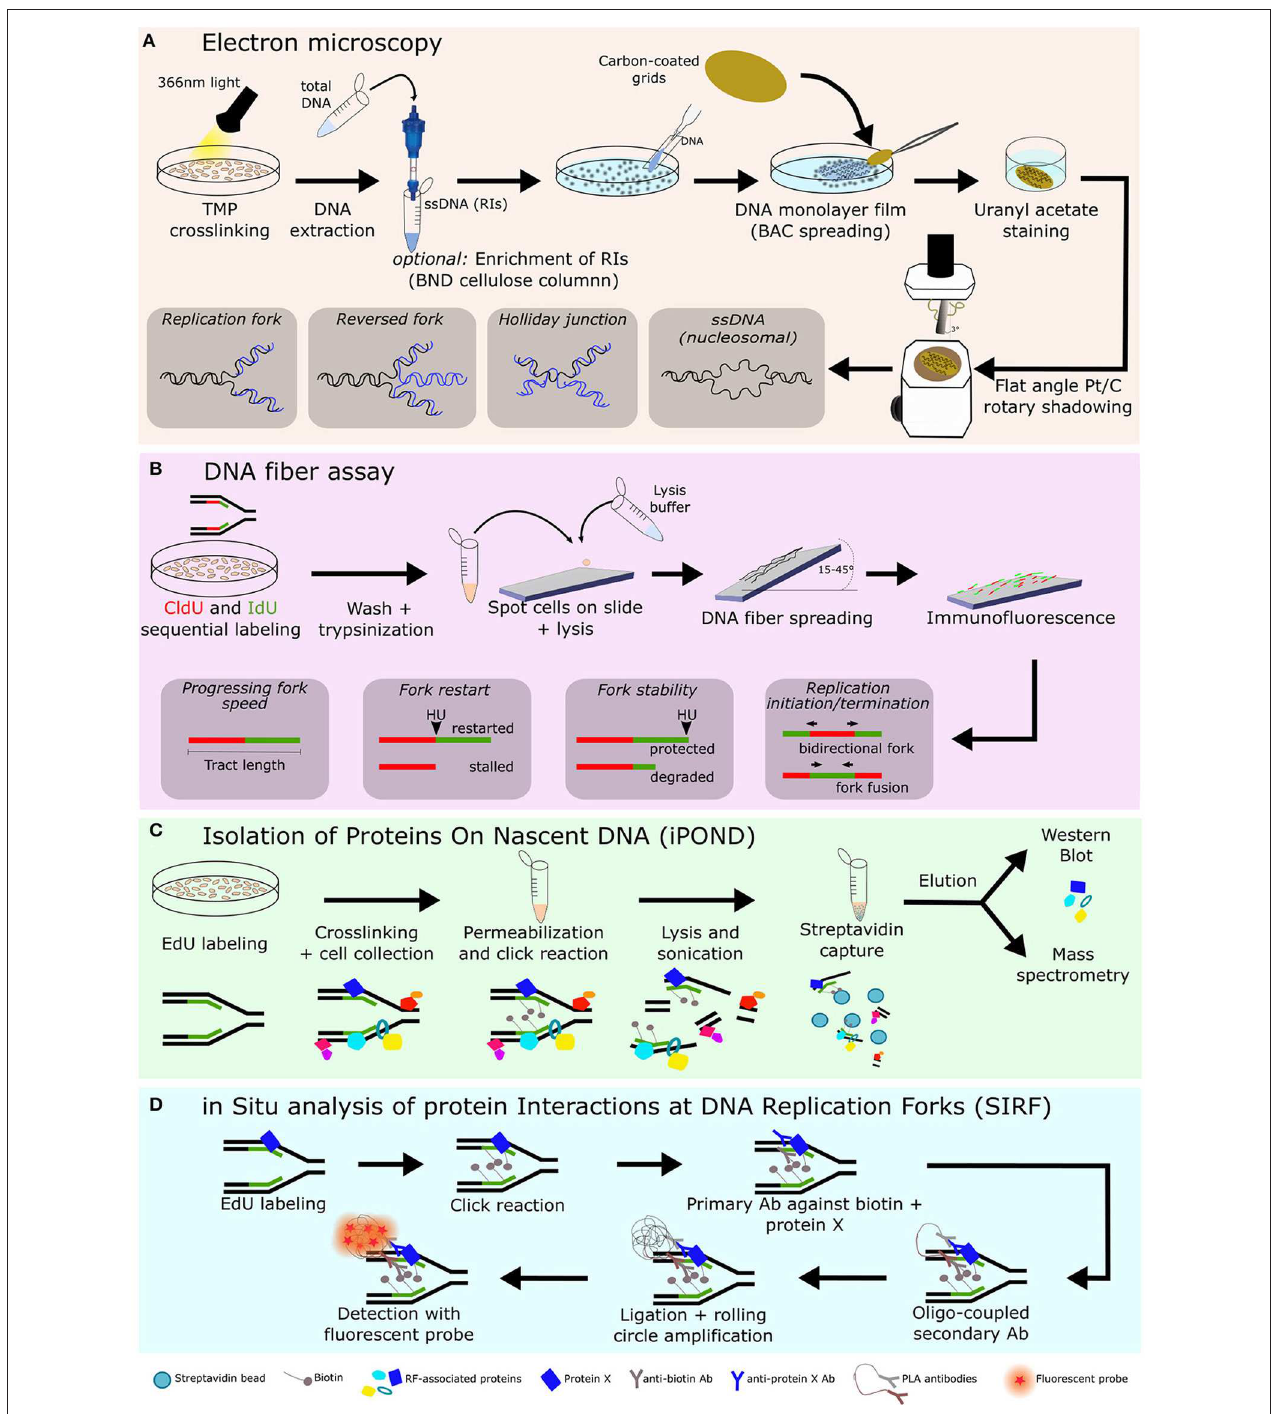
FIGURE 1 | Overview of techniques frequently used to study replication fork biology. Various methodologies, including electron microscopy (A) , single molecule DNA fiber assay, using the spreading technique (B) , iPOND (C) , and SIRF (D) , are being used to study replication fork-associated processes. Combining these techniques allowed many research groups to identify novel factors associated with replication forks and their role in replication fork dynamics and replication stress responses. Ab, antibody; BAC, benzyl-dimethyl- alkylammonium chloride; BND, benzoylated-naphthoylated DEAE; CldU, chlorodeoxyuridine; EdU, 5-Ethynyl-2 ′ -deoxyuridine; IdU, iododeoxyuridine; iPOND, isolation of proteins on nascent DNA; PLA, proximity ligation assay; Pt/C, Platinum/carbon; RF, Replication fork; RIs, replication intermediates; SIRF, in situ analysis of protein interactions at DNA replication forks; TMP, tri-methyl-psoralen.